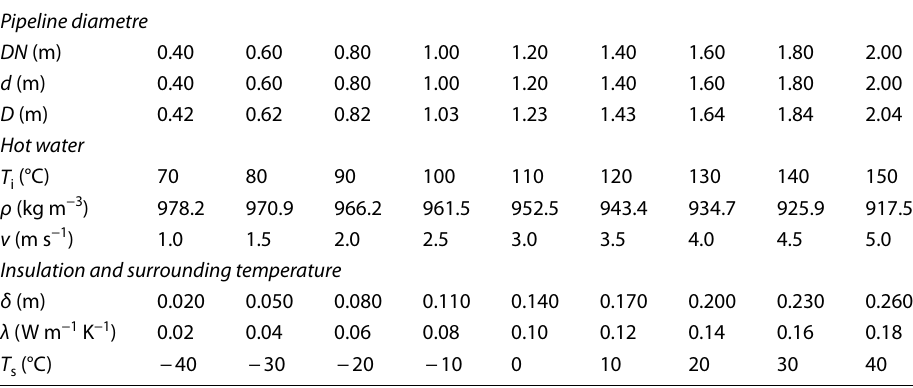
Table 1 Relative main parametres selected